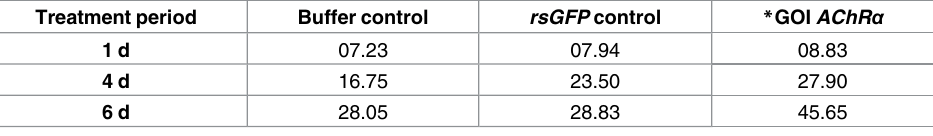
Table 3. Percentage mortality, post- AChR α dsRNA knockdown. Treatment